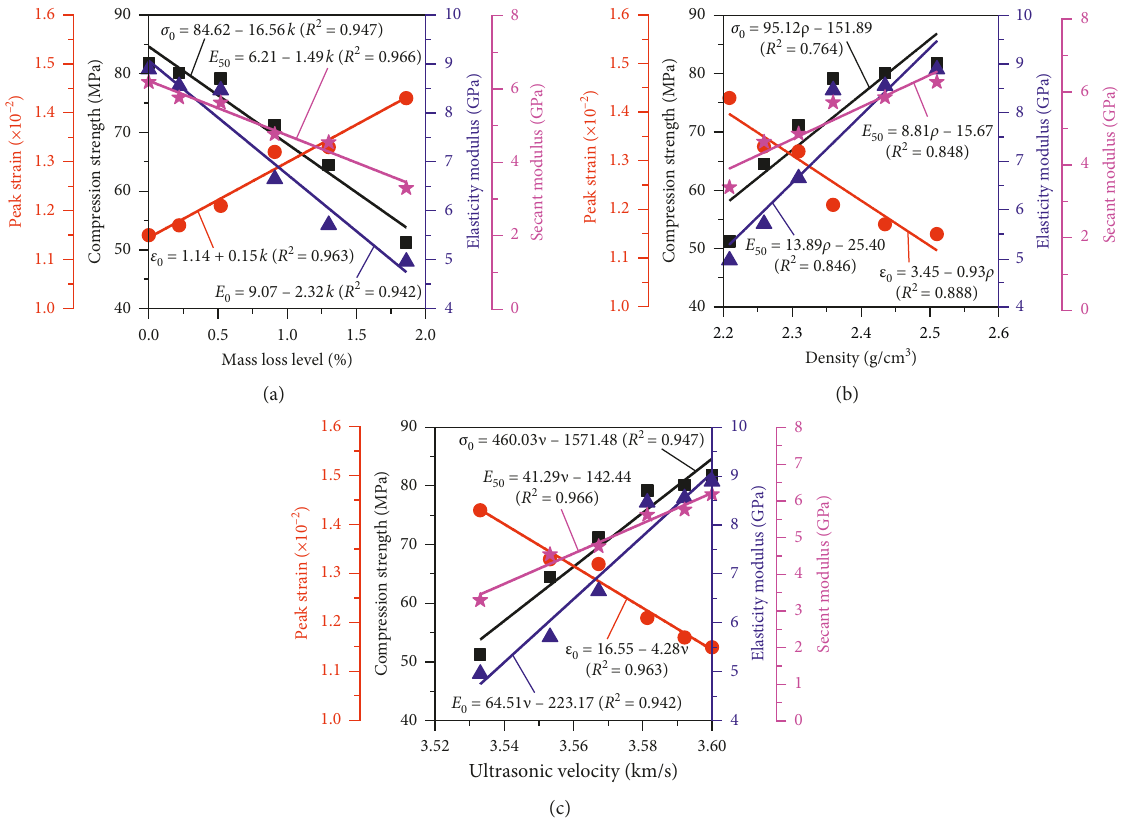
Figure 10: Relationships between physical and mechanical parameters. (a) σ